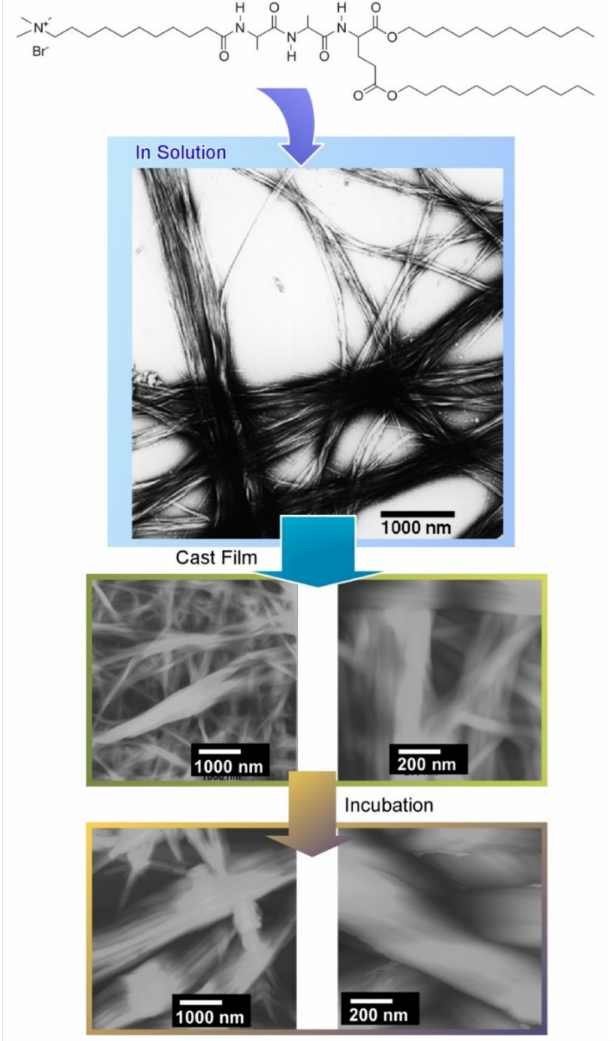
Figure 15. Hierarchic fibrous structures formed in solutions and cast films with molecules with tripeptide hydrogen bonding moiety within amphiphilic lipid